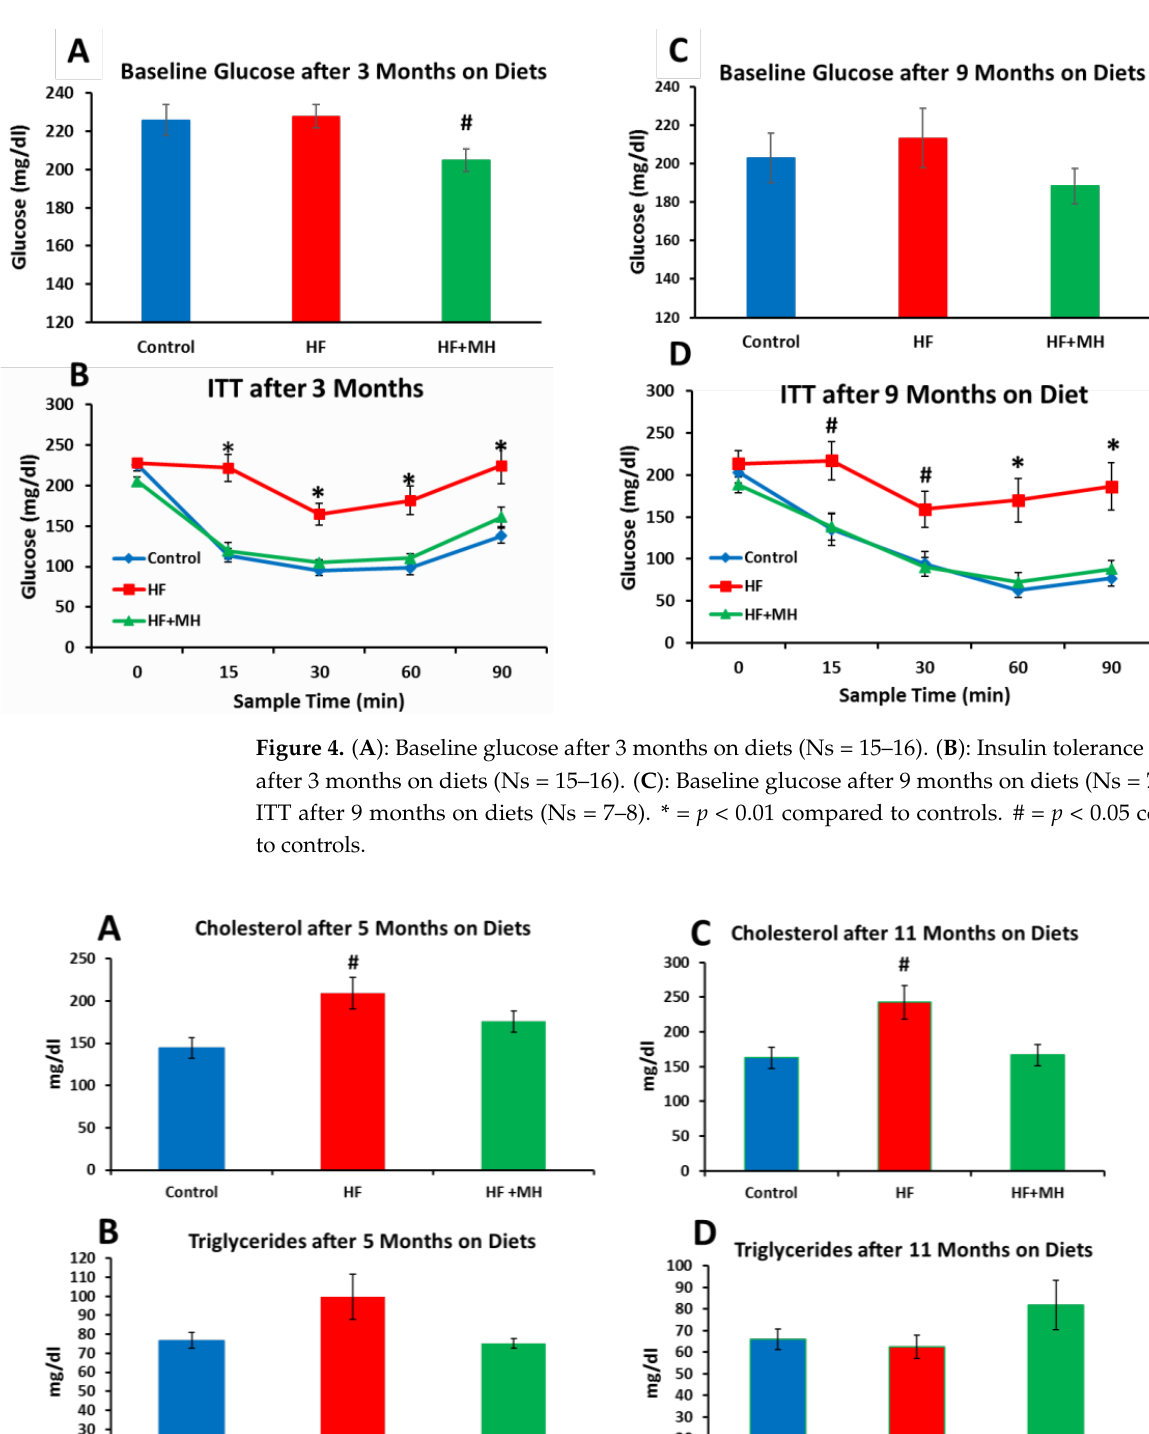
Figure 3. ( A ): Energy expenditure (kcal/hour) over 4 days in CLAMS. ( B ): VO 2 max (oxygen usage) over 4 days in CLAMS. ( C ): Respiratory expiratory ratio over 4 days in CLAMS. ( D ): locomotor activity over 4 days in CLAMS. * = p < 0.01 compared to Control group. (Ns = 4.).